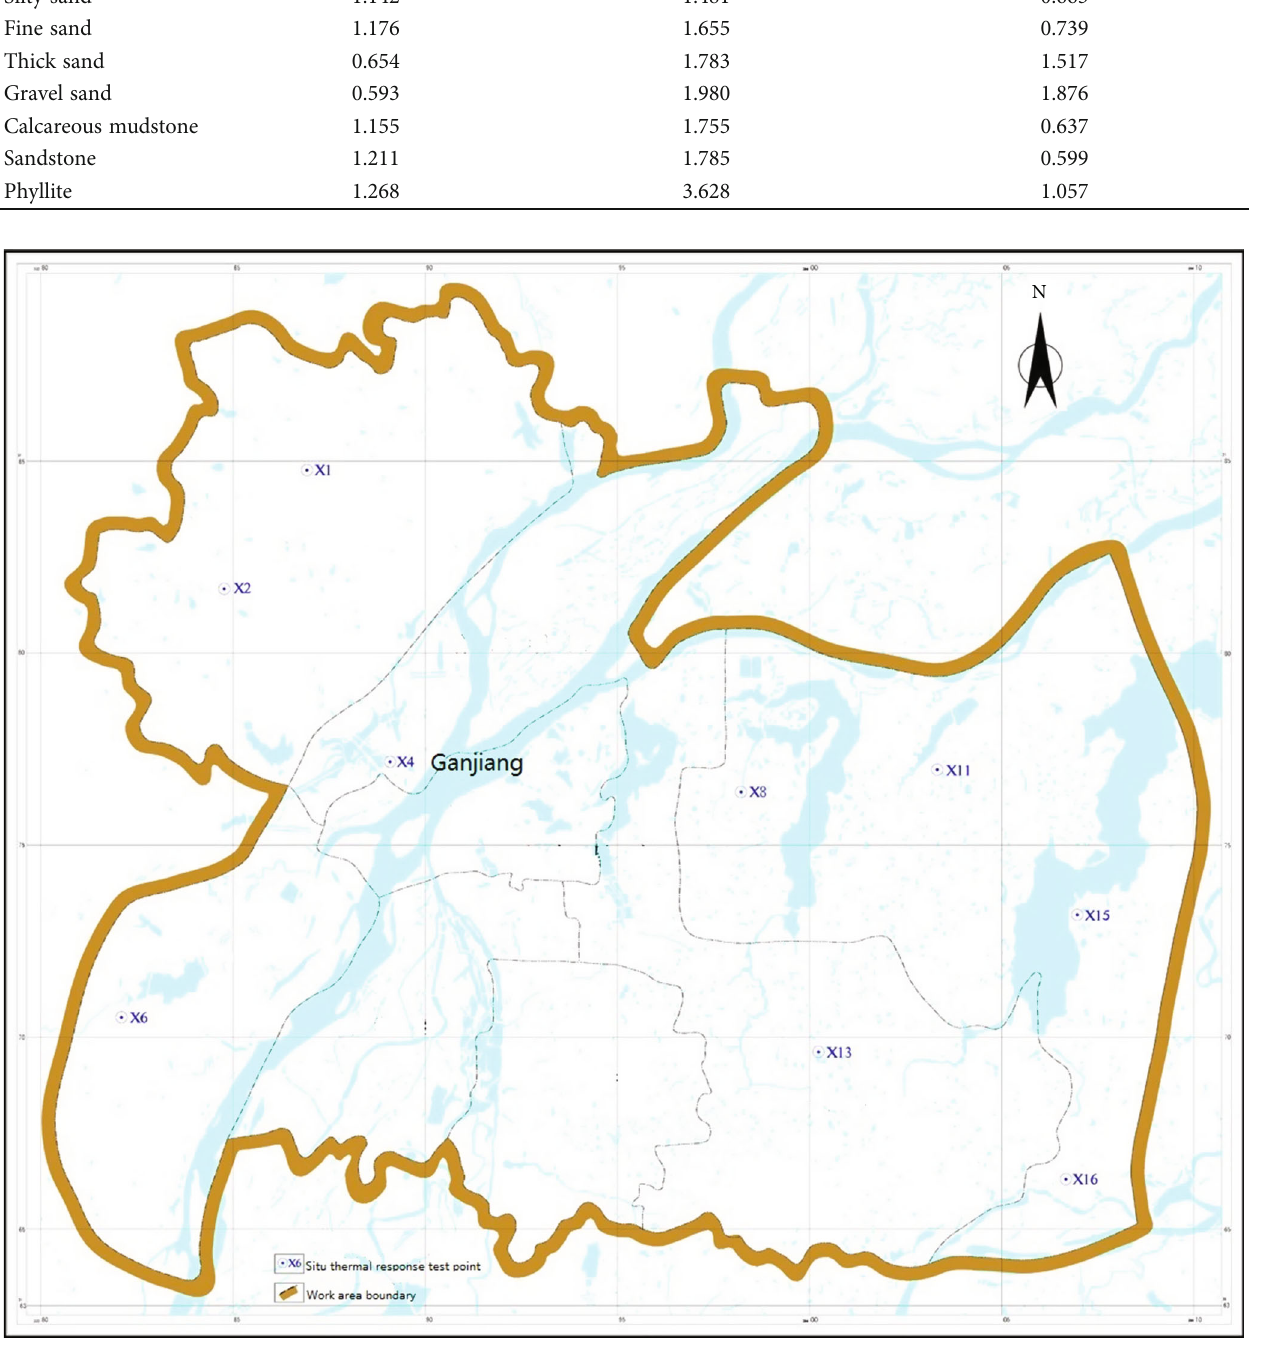
Figure 3: Distribution of the site thermal response